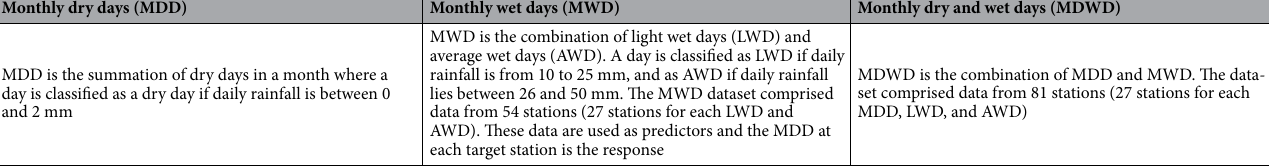
Table 7. Three datasets in this study to predict MDD at six target stations.